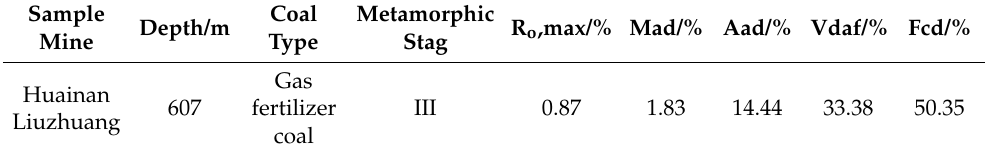
Table 2. Basic parameters of coal sample.